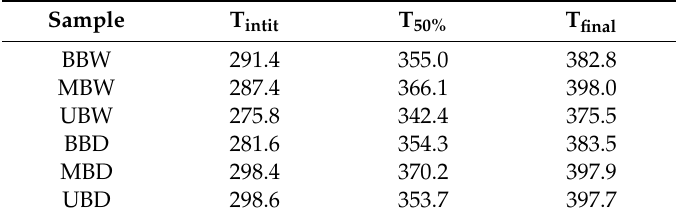
Figure 7. Representative curves of analyzed samples in thermo-oxidative conditions. Characteristic temperatures (average values) of main stage thermal degradation of analyzed